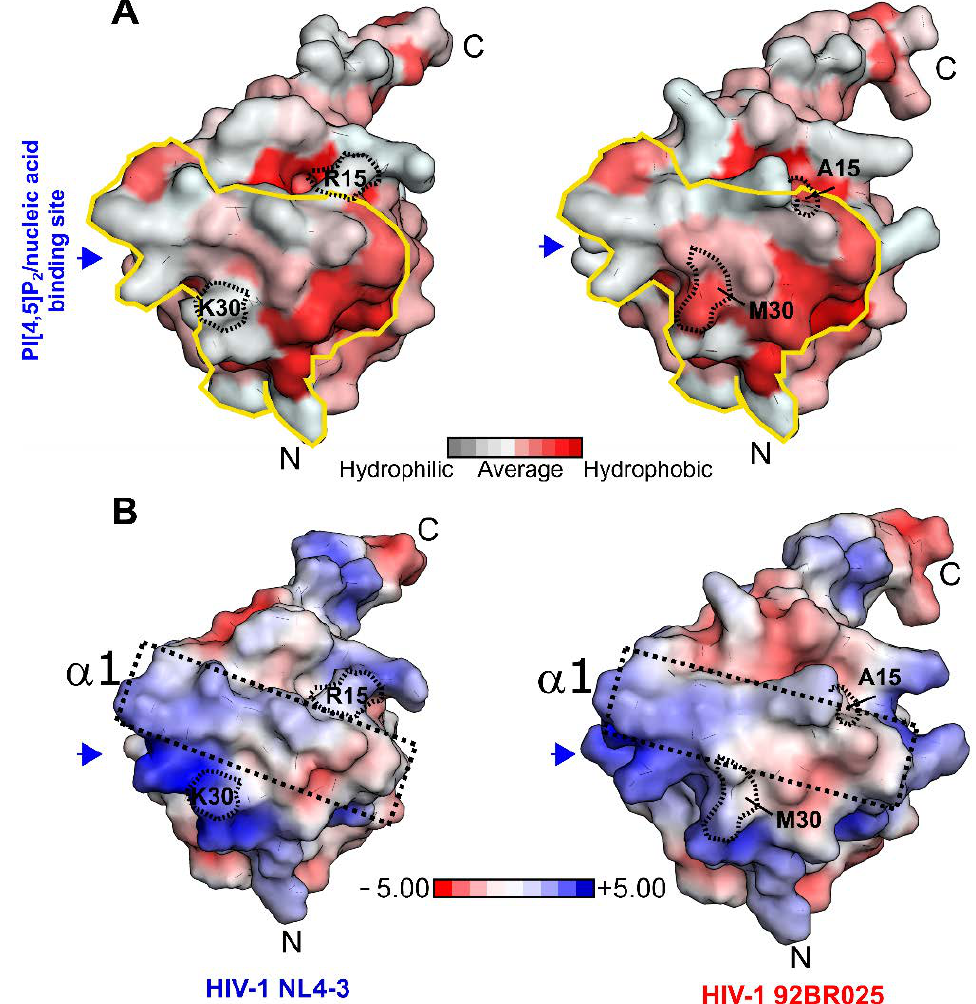
Figure 4. Surface conservation plot and electrostatic surface potential of the HIV-1 MA protein. ( A ) Hydrophobicity plot mapped on the solvent-accessible surface of the HIV-1 MA (NL4-3) structure (left panel, PDB code: 1HIW) and in this study generated homology model of clade C (92BR025.8, right panel) [48]. ( B ) The electrostatic surface potential of HIV-1 MA clade B (NL4-3) (left panel, PDB code: 1HIW) and in this study generated homology model of clade C (92,BR025.8, right panel). N- and C-termini are highlighted with an N or C, respectively. Box highlights helix α 1 and loop region between α 1 and α 2. The electrostatic potential is shown between − 5 kcal/mol*e (red) to +5 kcal/mol*e (blue). The electrostatic surface calculation was performed at 310K and 150 mM Salt concentration with APBS [38]. The blue arrow indicates the (PI[4,5]P2)/nucleic acid binding site and the solid yellow line the CaM binding